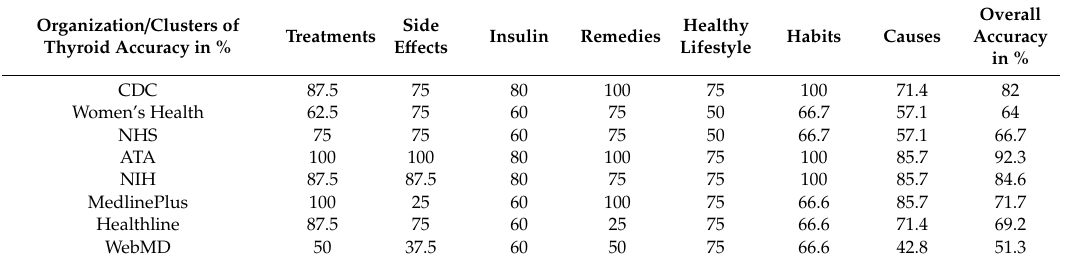
Table 5. Comparison of thyroid keywords with di ff erent healthcare organization.